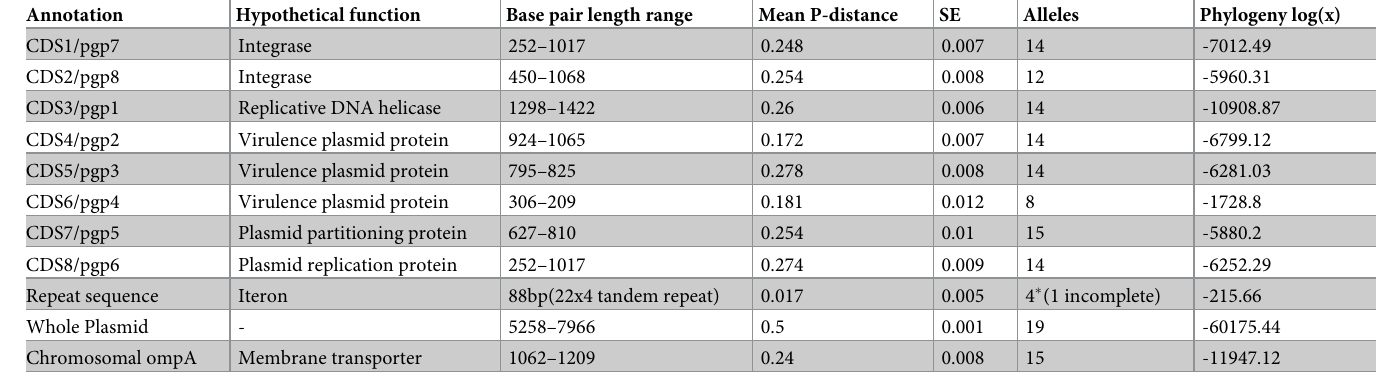
Table 2. Annotation of each element of the plasmid. This includes the putative function and length of each element. The table includes the results of the average p-dis- tance, alleles present and log likelihood of tree